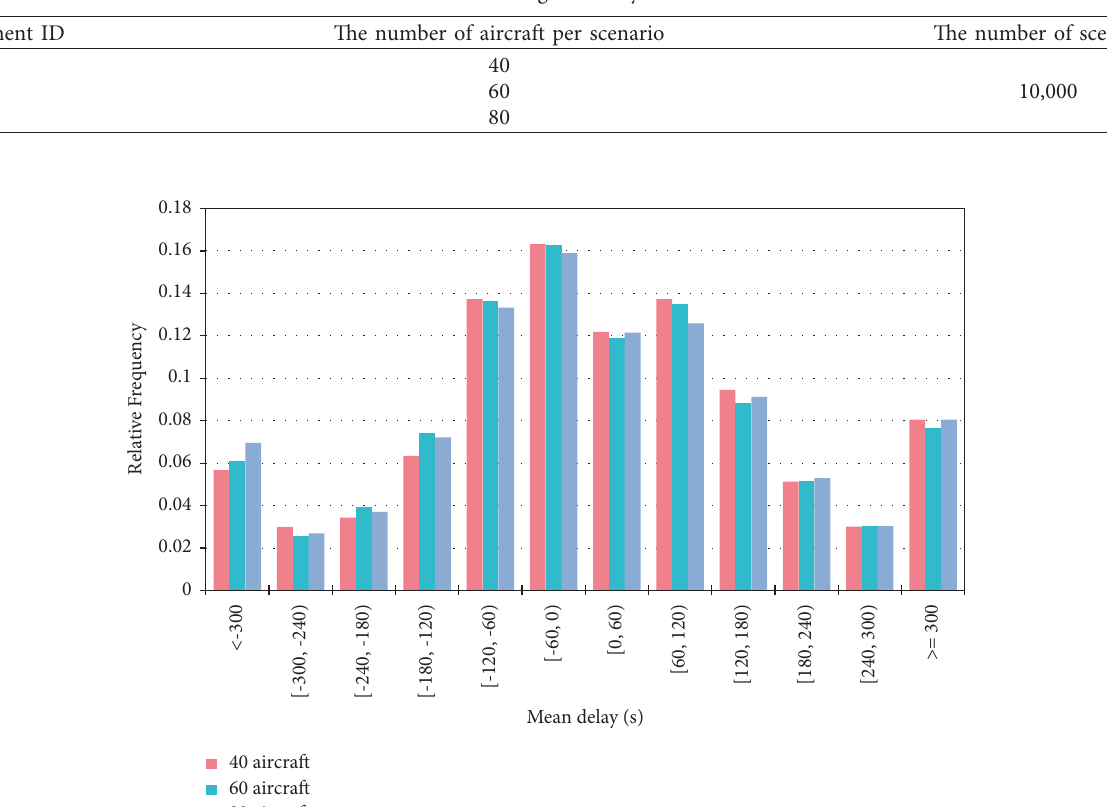
Figure 13: Schematic diagram of delay. Table 5: The design of delay for CR.